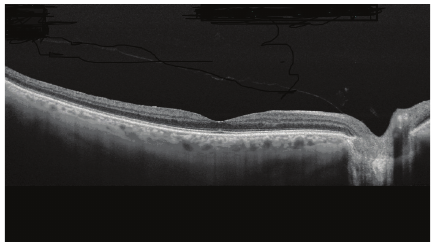
Figure 2: Study of the retinal surface with swept-source OCT showing posterior vitreous detachment, which remains attached at the papillary